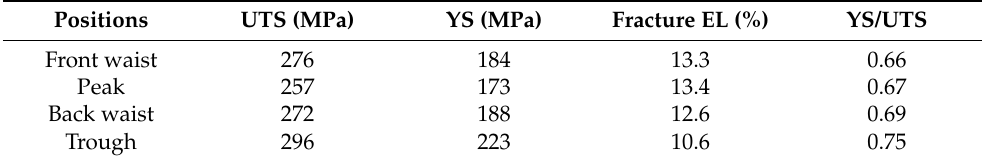
Table 2. Transverse tensile properties statistics at four positions of the corrugated clad sheet.